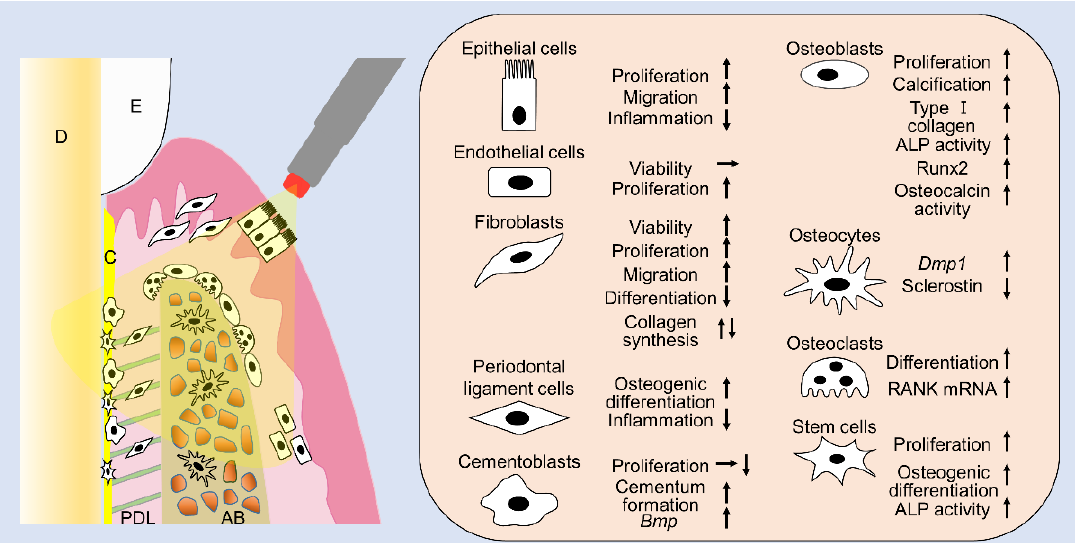
Figure 1. The summary of this review. Laser irradiation has various effects on cells related to periodontal tissues. E: enamel, D: dentin, PDL: periodontal ligament, AB: alveolar bone.